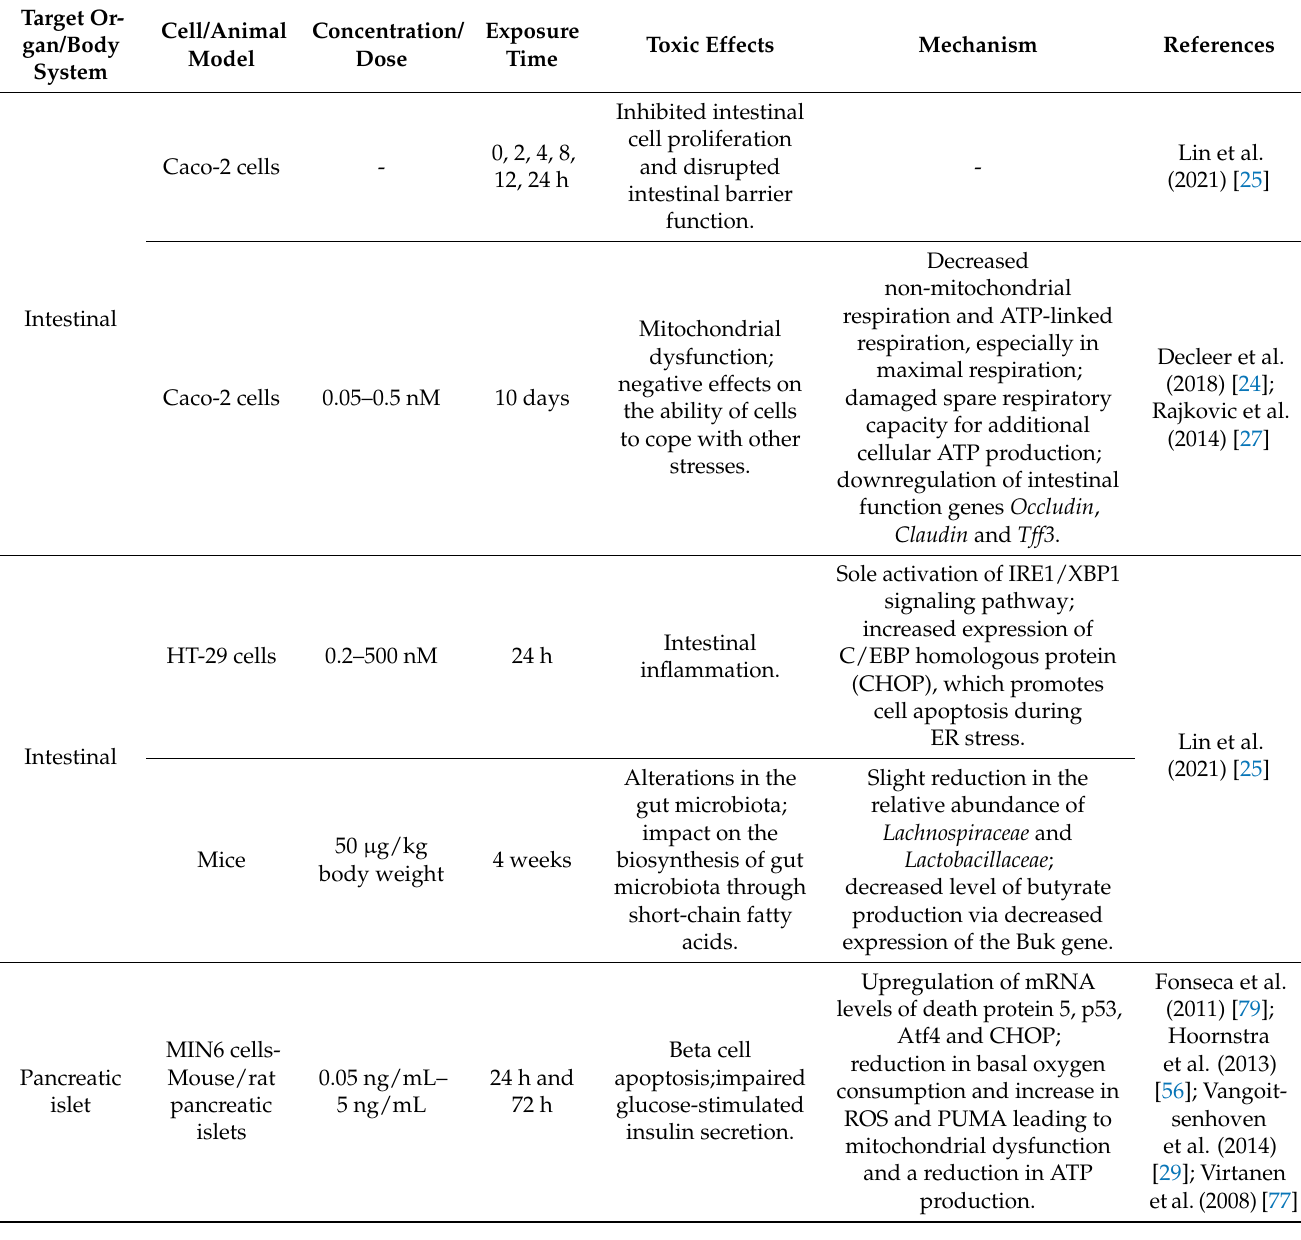
Table 1. Representative adverse effects caused by cereulide at the organ or system level and their potential